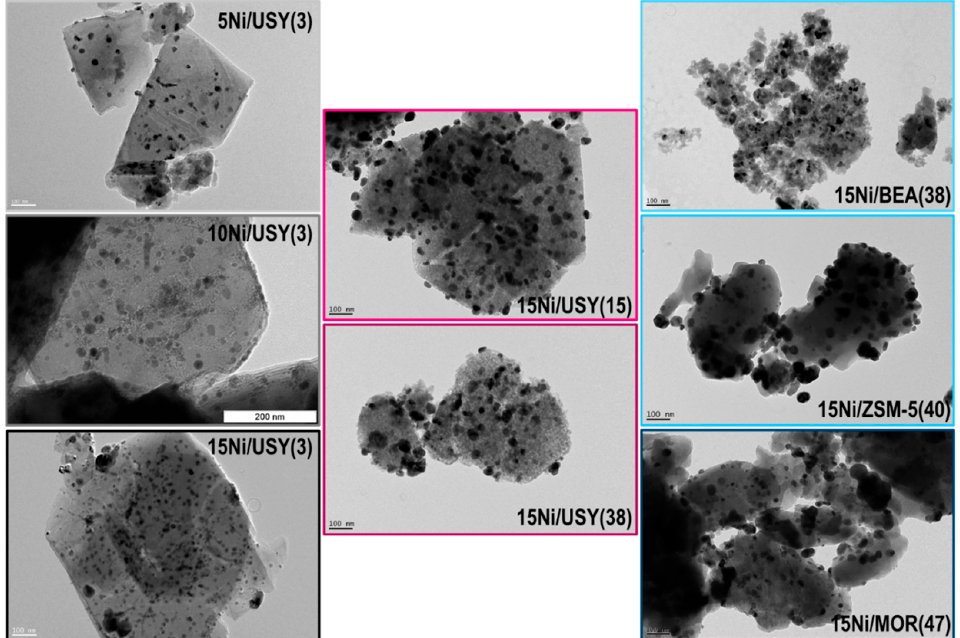
Figure 5. TEM micrographs collected for the samples from the present work after reduction with H 2 at 470 °C.